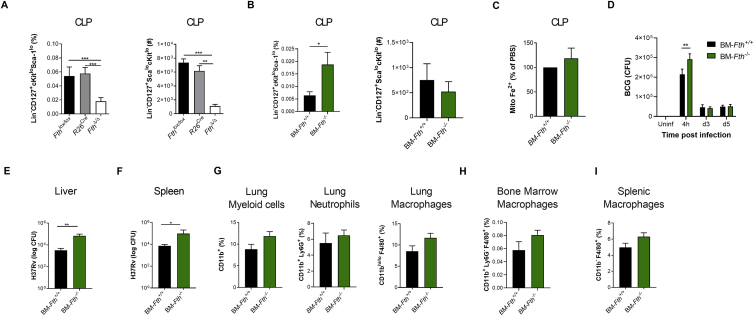
Loss of Iron Homeostasis Disrupts Myelopoiesis, Related to Figure 6(A) Frequency (left panel) and total cell count (right panel) of CLP in FthΔ/Δ, R26cre or Fthlox/lox mice as generated in Figure 6A. (B-G) BM-Fth+/+ or BM-Fth−/− chimeric mice were generated as described in Figure 6D. Frequency (left panel) and total cell count (right panel) of CLP in BM-Fth+/+ or BM-Fth−/− chimeric mice (B). (C) Relative percentage of iron (Fe2+) specific dye in the mitochondria of CLP in the BM of BM-Fth−/− compared to BM-Fth+/+ mice. (D) BCG CFU (infection at MOI 10) in BMDM from BM-Fth+/+ or BM-Fth−/− mice at the indicated time points. CFU in the liver (E) and spleen (F) following 28 days of aerosol Mtb infection. Frequency of myeloid cell populations in the lung (G), BM (H) and spleen (I) of naive BM-Fth+/+ and BM-Fth−/− mice. Differences assessed by One-way ANOVA followed by Tukey’s Multiple Comparisons Test (A), Two-tailed Student’s T-Test (B-C and E-I), or Two-way ANOVA followed by Sidak’s Multiple Comparisons Test (D).